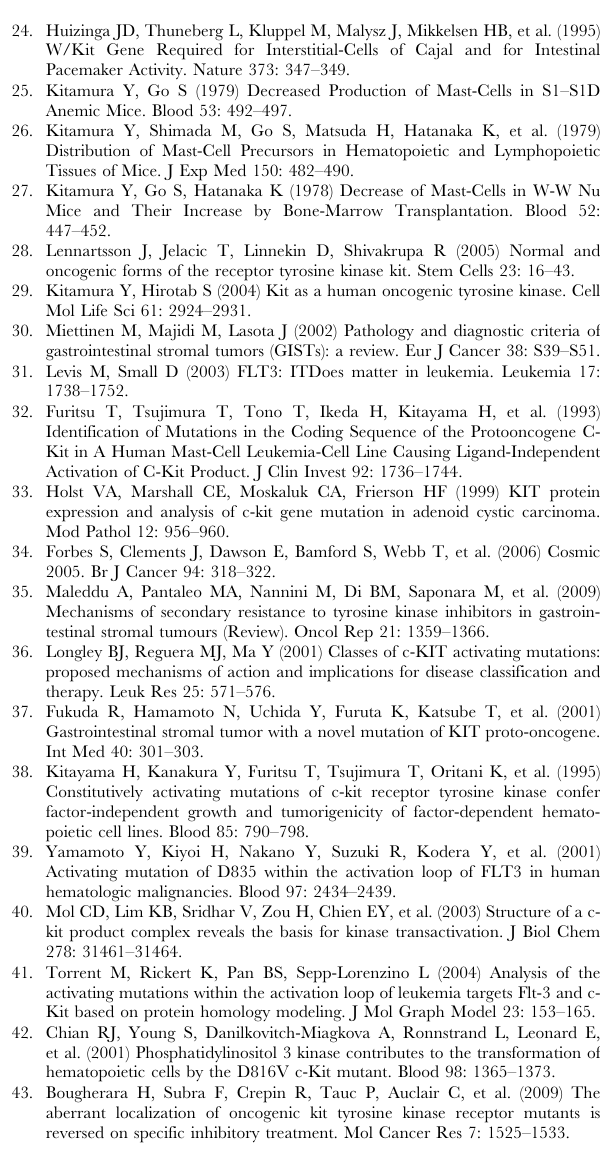
red color indicates the direction followed to the extreme conformations represented on Figure 8, which are labeled as red crosses. (TIFF) Figure S6 Pockets detected on the surface of wild-type and D816V-mutated KIT receptor truncated cytoplasmic region. Left Panel: the wild-type, WT 567–935 . Right Panel: the mutant D816V, MU 567–935 . Conformations were extracted after 50 ns of MD simulation. The core of the protein is in cyan, JMR is in orange and A-loop is in red. Pockets are displayed in red when they overlap with the catalytic site, in orange when they are located between the catalytic site and JMR, in olive, green or purple when they overlap with the substrate binding site. (TIFF) Table S1 MD preparation and equilibration details. The counter-ions employed to neutralize the systems are Na + and Cl 2 . Root mean square deviations were computed on the